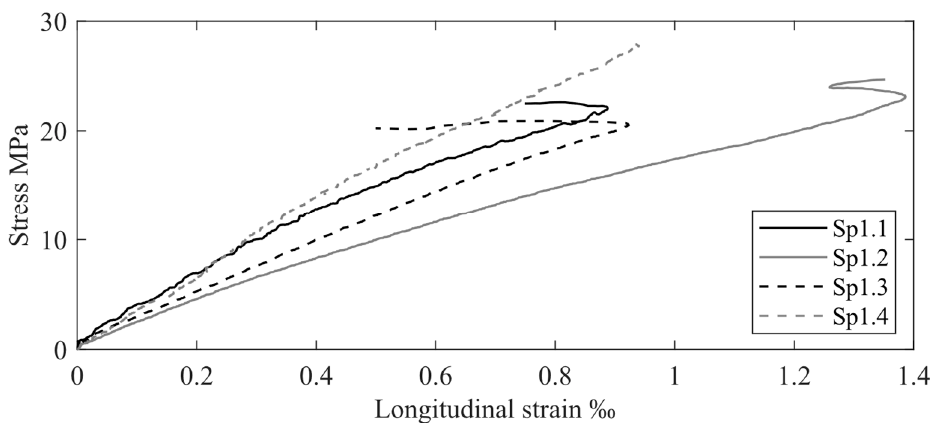
Figure 4. Experimental dependences σ c vs. ε c .